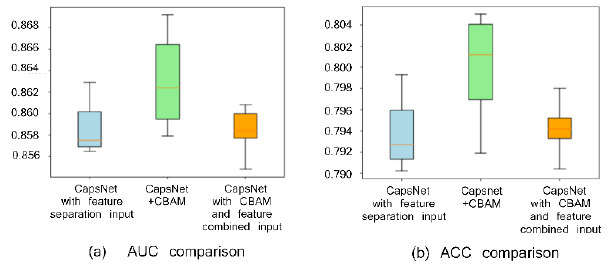
Figure 1. Comparison with or without CBAM and with or without feature separation input on the peptide detectability prediction for the test set from GPMDB. The blue, green, and orange groups are the results by CapsNet + feature separation input, CapsNet + CBAM + feature separation input, and CapsNet + CBAM + feature combined input, respectively.